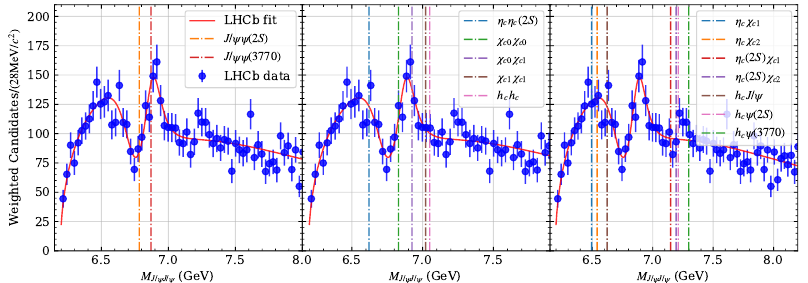
Figure 2: The LHCb data and best fit reported in Ref. [ 1 ] superposed with the double- charm thresholds residing in the energy range from 6.2 to 7.2 GeV. Only relevant thresholds are retained in the left plot (see the text for details) while additional (not considered) S - and P -wave thresholds are given in the middle and right plot, respec-